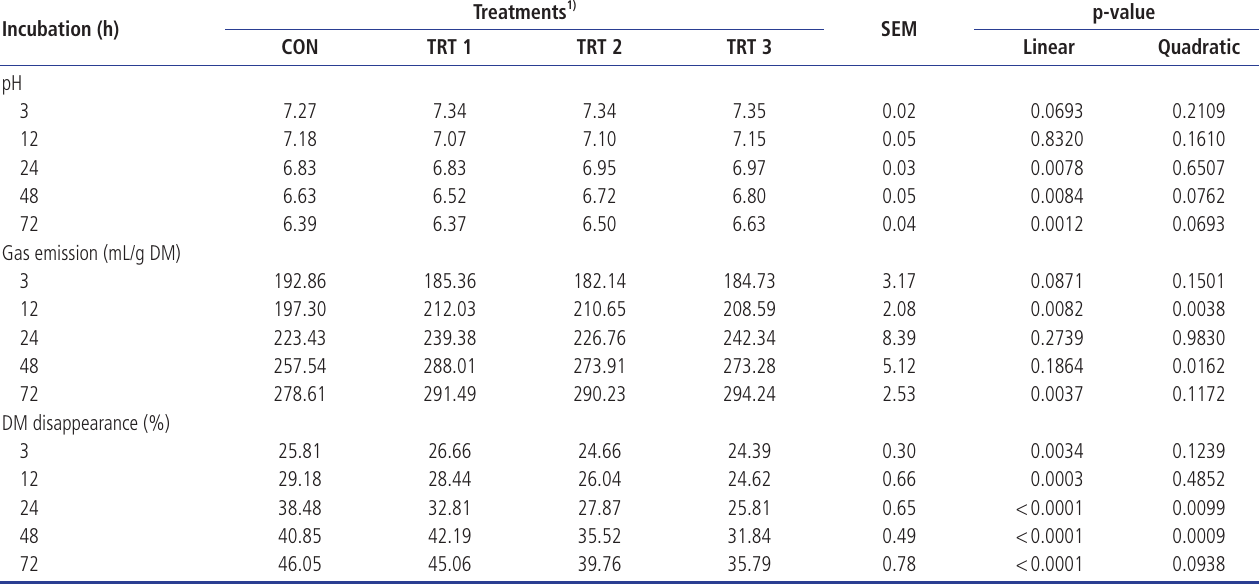
Table 2. Effect of Gelidium amansii extract on in vitro cumulative pH, gas emission, dry matter disappearance by mixed rumen microbial fermentation Incubation